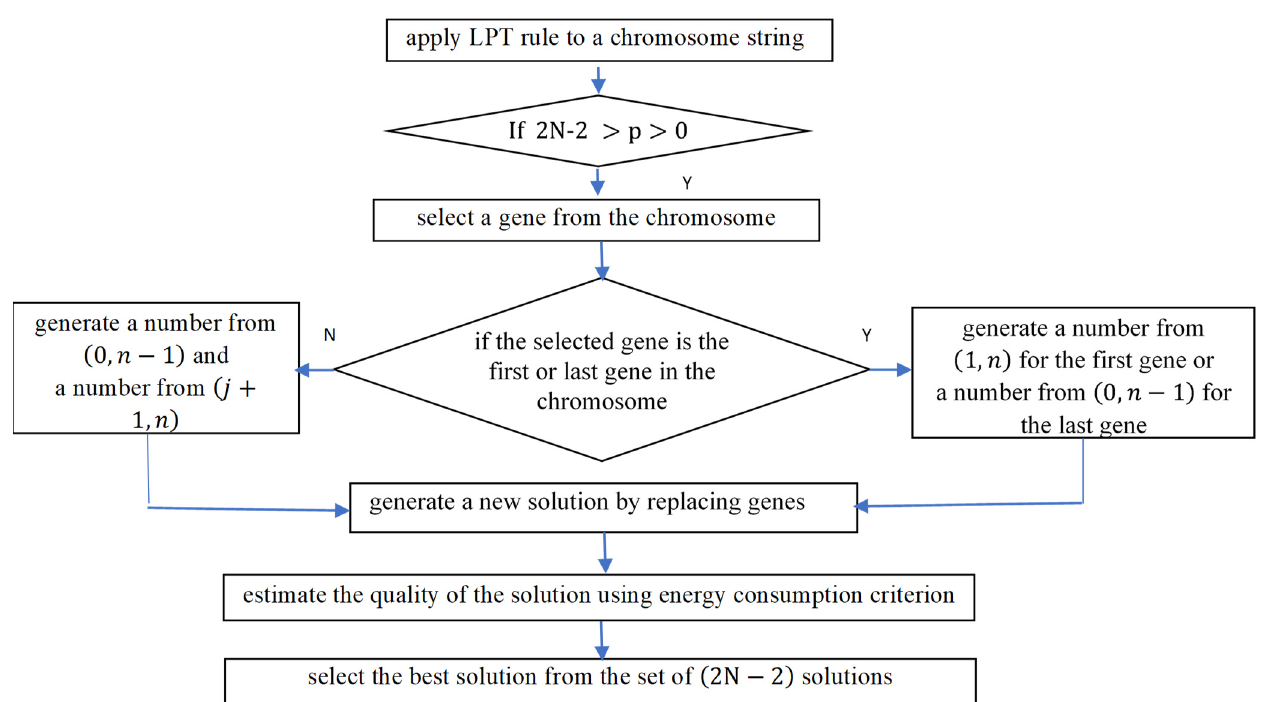
Figure 6. Block diagram of the RIPS procedure.